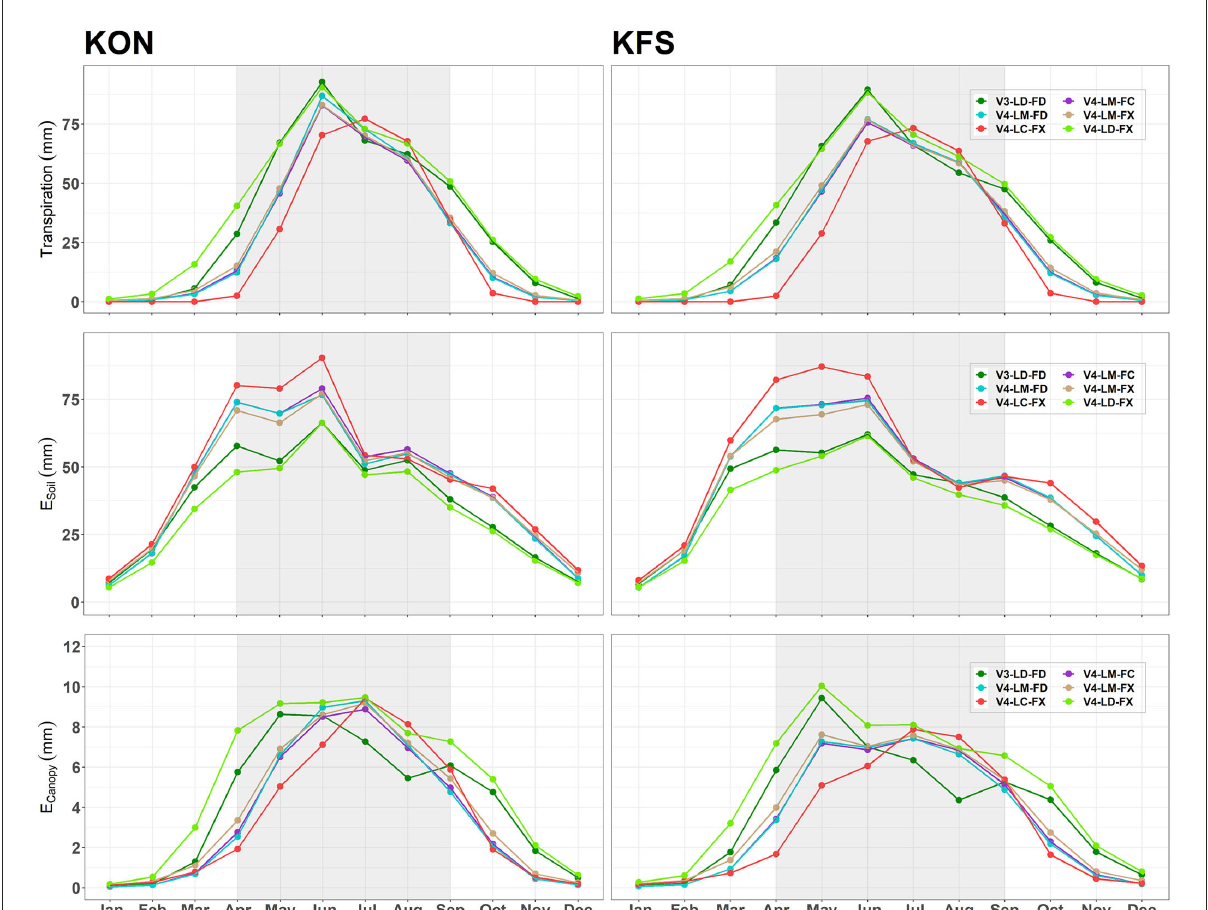
FIGURE4 Seasonal climatology of simulated Transpiration, E canopy , and E soil from different Noah-MP configurations vs. MODIS and EC measurements during the 11-year study period for KON and KFS sites. Gray-shaded areas denote the growing